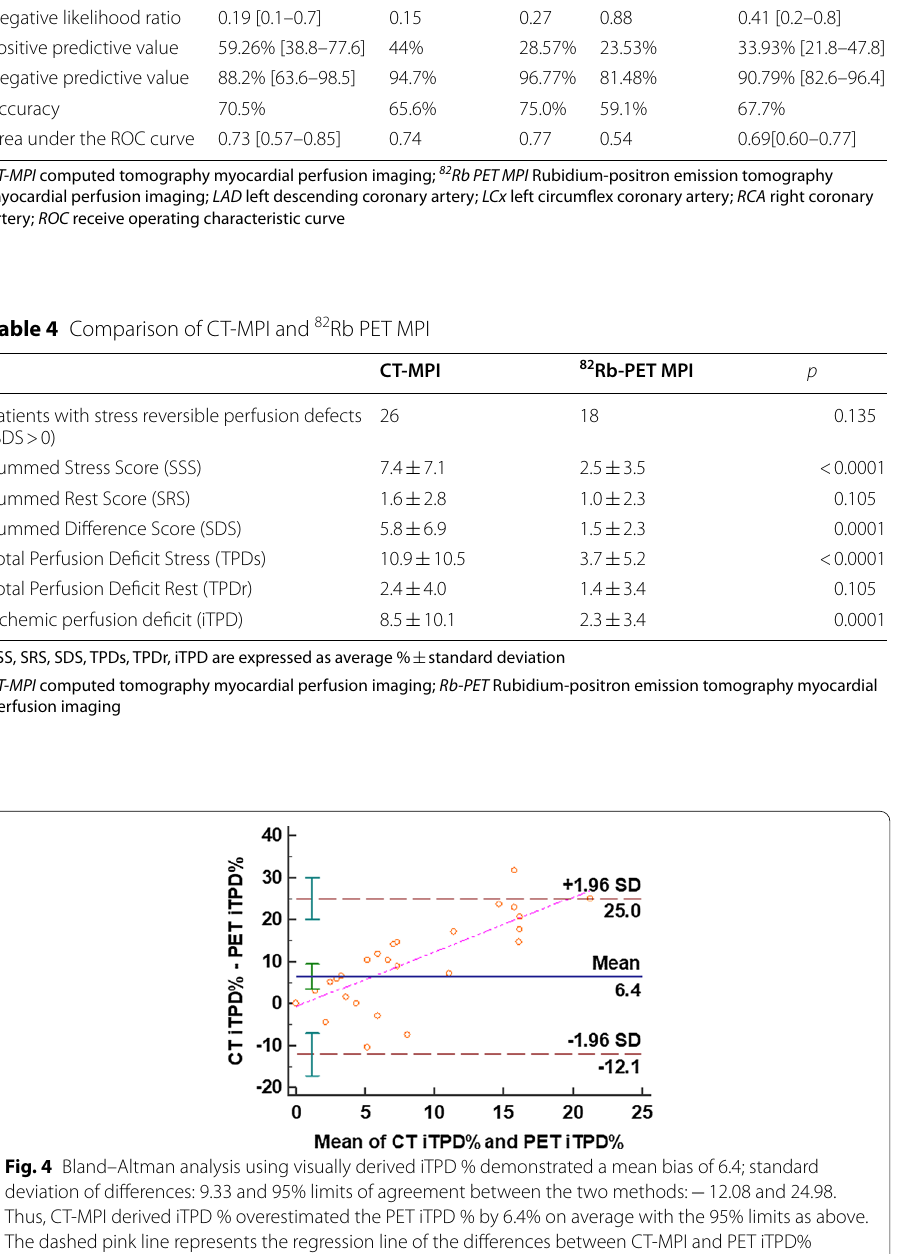
Fig. 4 Bland–Altman analysis using visually derived iTPD % demonstrated a mean bias of 6.4; standard deviation of differences: 9.33 and 95% limits of agreement between the two methods: Thus, CT-MPI derived iTPD % overestimated the PET iTPD % by 6.4% on average with the 95% limits as above. The dashed pink line represents the regression line of the differences between CT-MPI and PET iTPD% which shows a positive trend representing that the CT-MPI derived iTPD% overestimation increased with an increasing average of CT-MPI and PET iTPD%. CT computed tomography; MPI myocardial perfusion